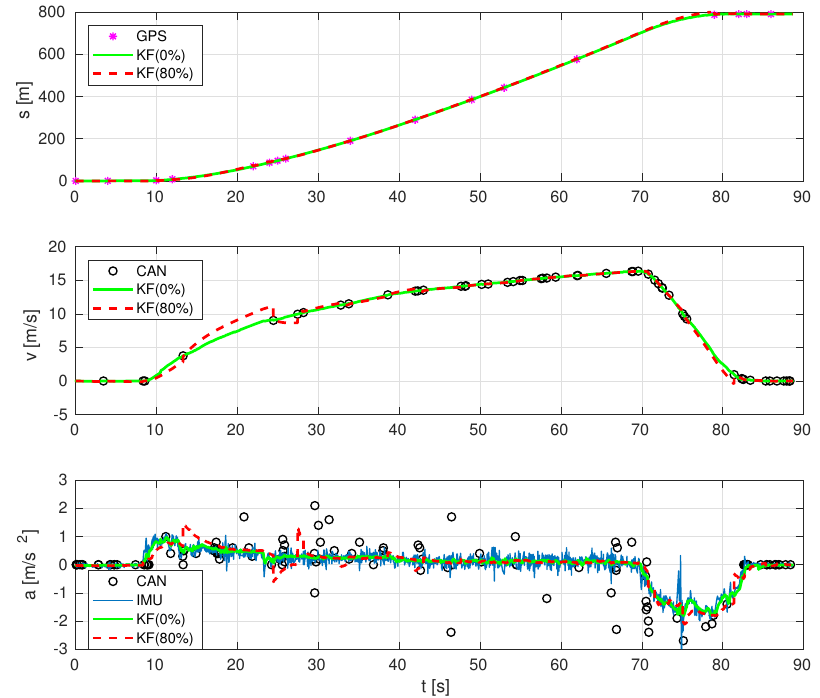
Figure 12. Estimation at a high rate of vehicle’s position, velocity and acceleration, with 80% of data